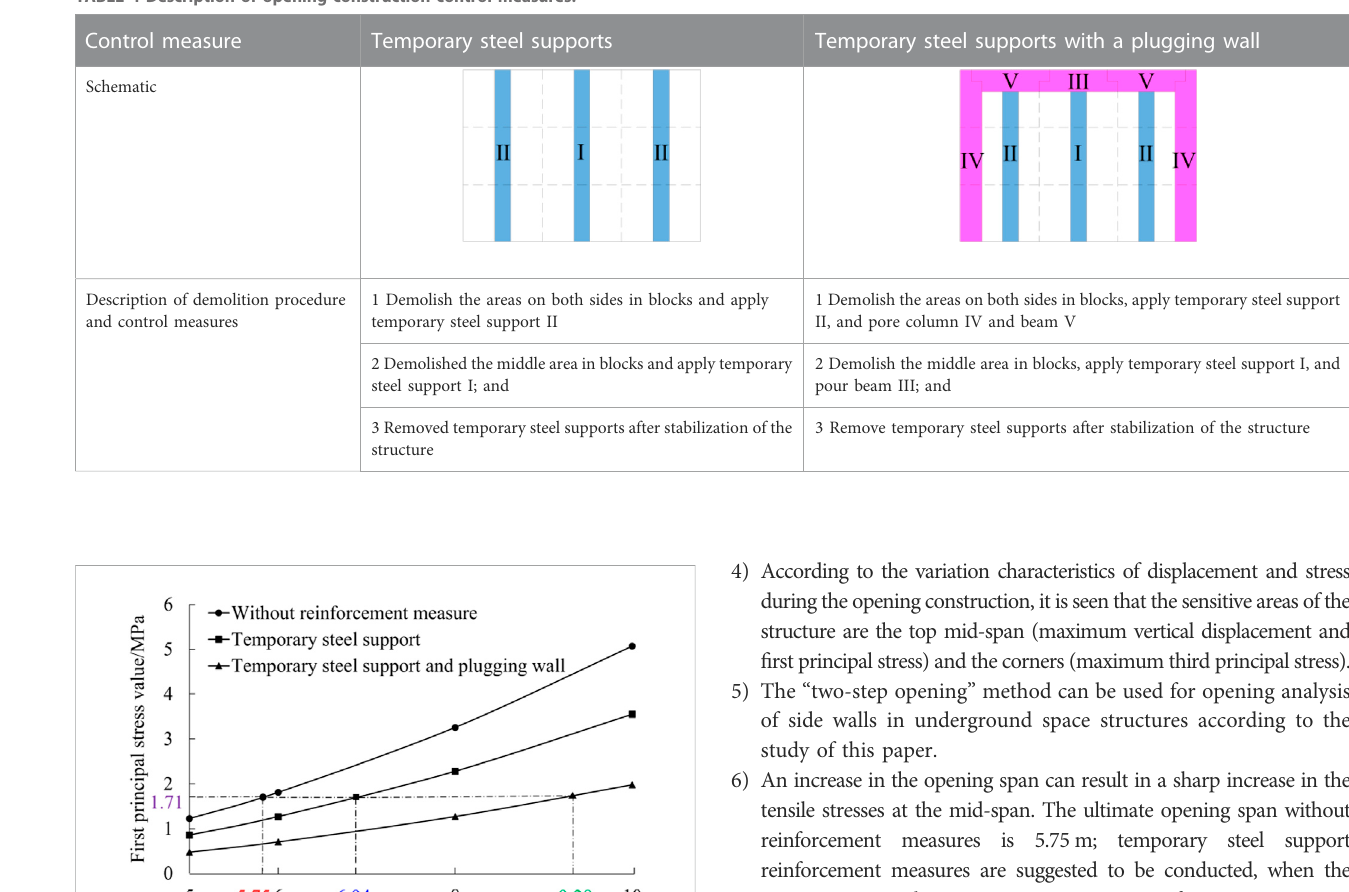
TABLE 4 Description of opening construction control